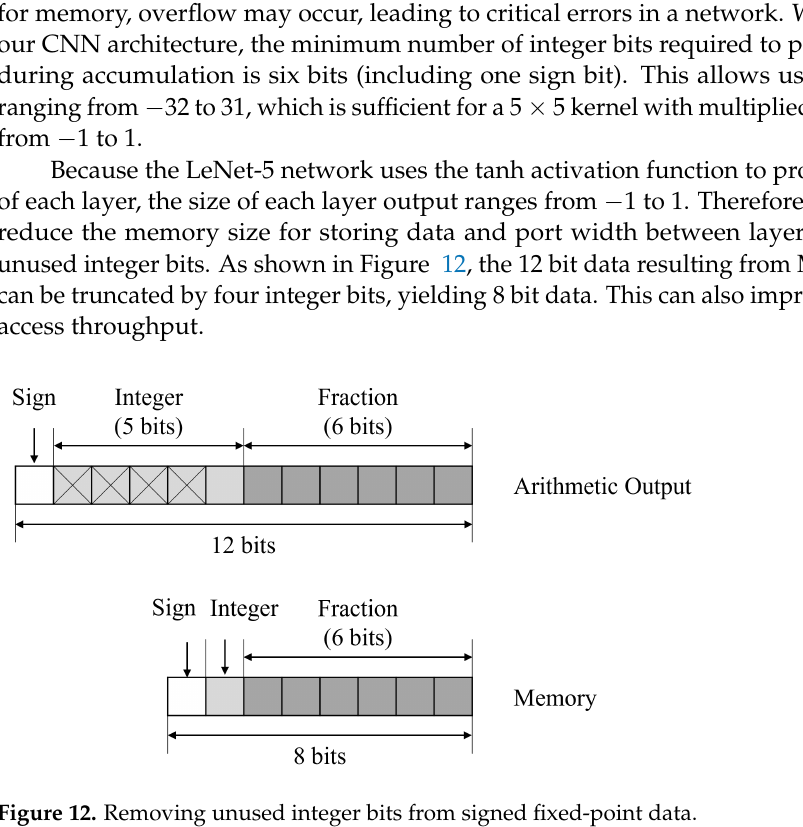
Figure 12. Removing unused integer bits from signed fixed-point